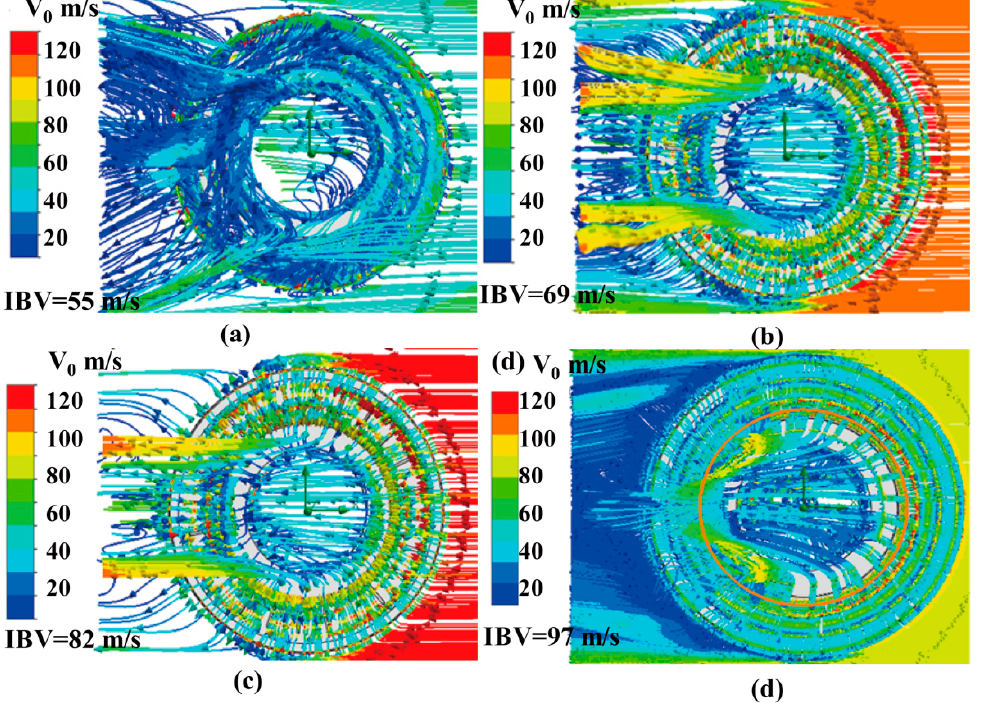
Figure 10. 3D streamlines of the air around brake disc at t = 5 s after start of braking: ( a ) initial braking velocity (IBV) = 55 m / s; ( b ) IBV = 69 m / s; ( c ) IBV = 82 m / s; ( d ) IBV = 97 m /